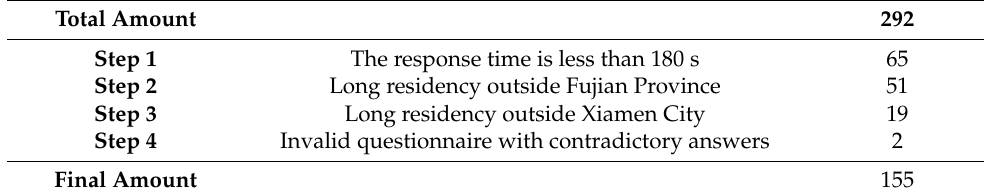
Table 7. The process of screening of obtained responding